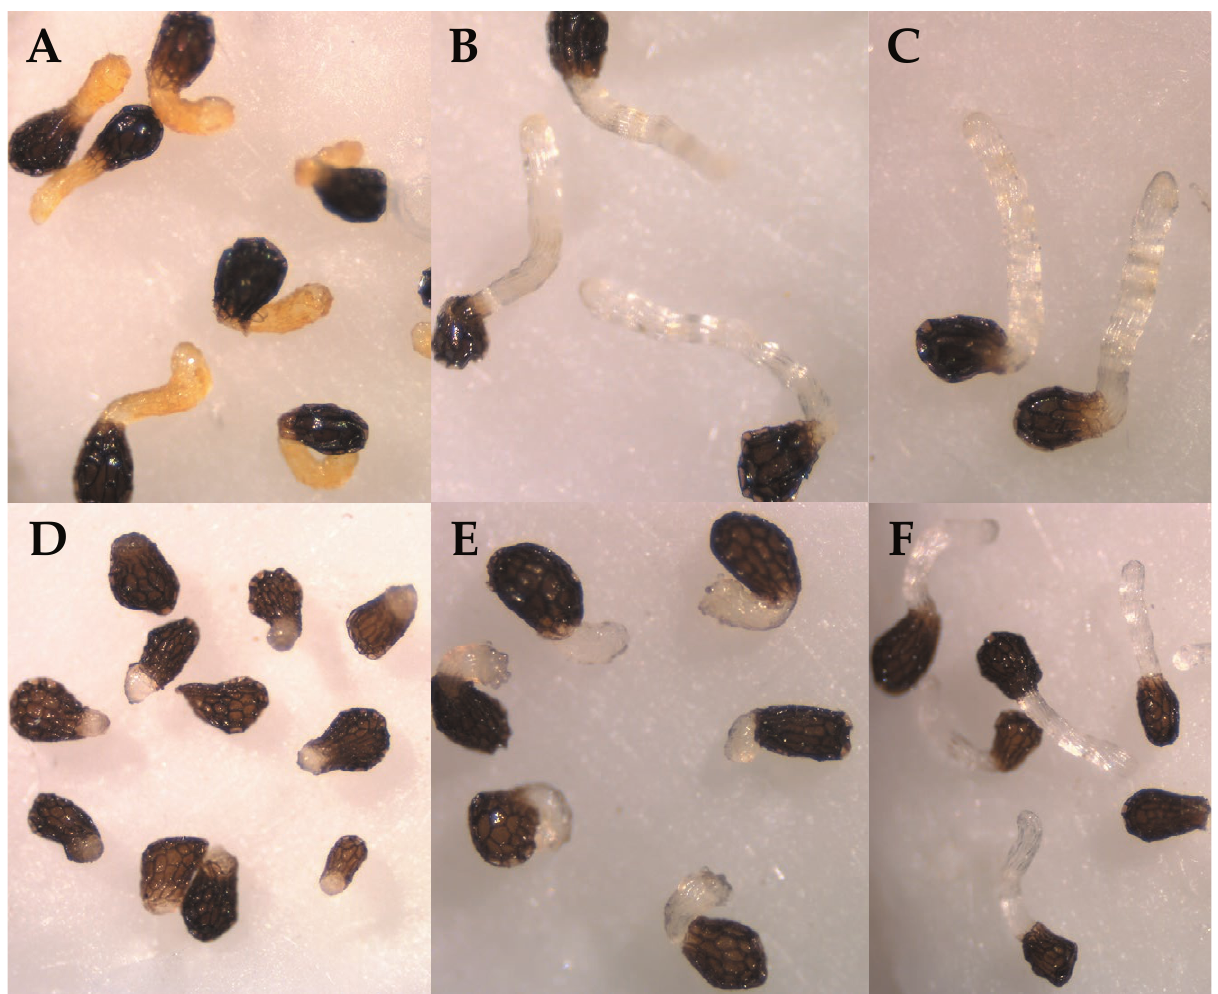
Figure 3. Photographs illustrating effects of CH 2 Cl 2 organic extracts from roots of Convolvulus arvensis L. (A and D), and Portulaca olera- cea L. (B and E), both compared with respective experimental controls (C and F) on radicle growth of (A-C) Orobanche crenata Forsk. and (D-F) Phelipanche ramosa (L.) Pomel